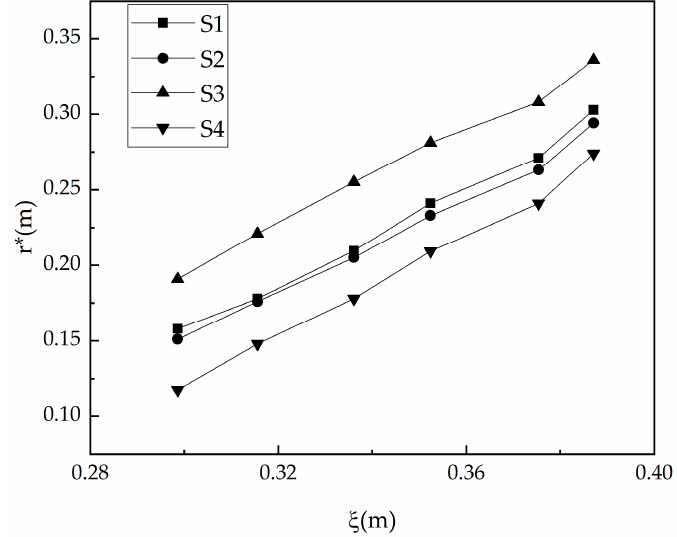
Figure 17. The wetted length as a function of the penetration depth for different sections.